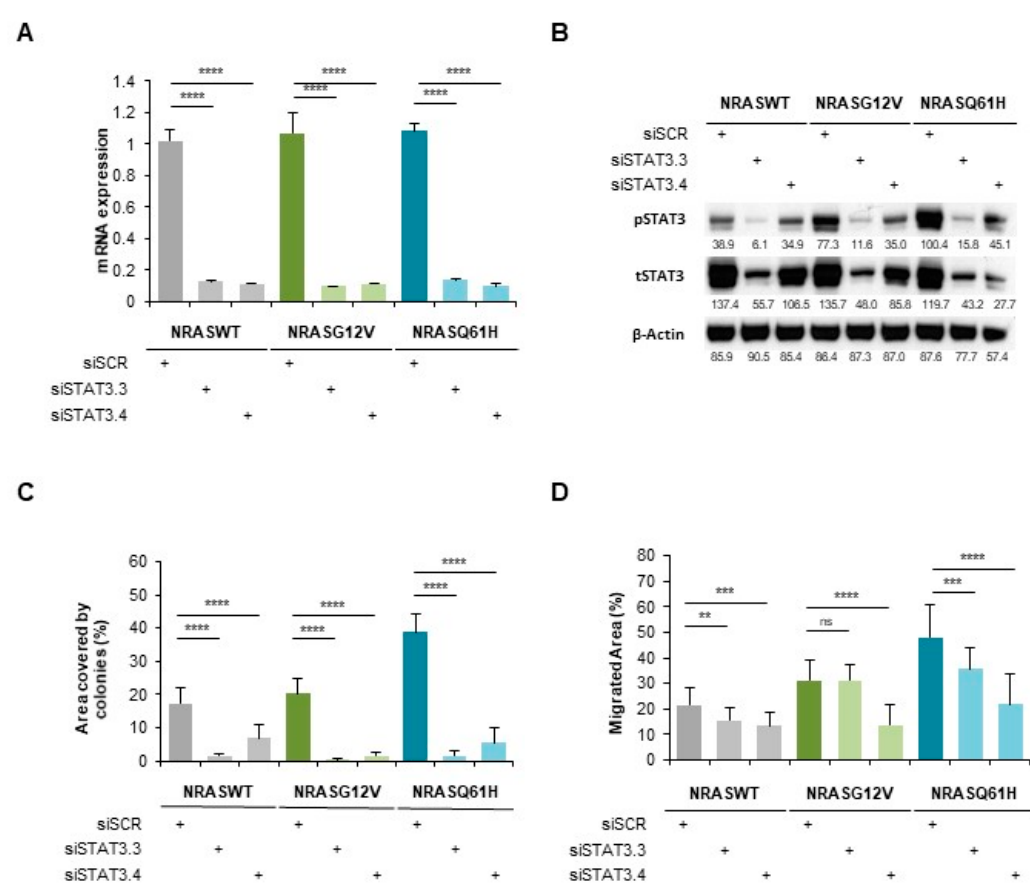
Figure 3. STAT3 is involved in NRAS- driven migration and colony formation of immortalized melanocytes MelSTV. ( A ) mRNA expression of STAT3 in immortalized melanocytes MelSTV expressing either NRASWT , NRASG12V or NRASQ61H , after 48 h transfection with siSTAT3 (siSTAT3.3 and siSTAT3.4). ( B ) Phospho-STAT3 and STAT3 levels shown by Western Blot in the same conditions as in A. ( C ) Colony formation assay of MelSTV in the same conditions as in A. ( D ) Migration of MelSTV in the same conditions as in A. ** p < 0.01, *** p < 0.001, **** p <